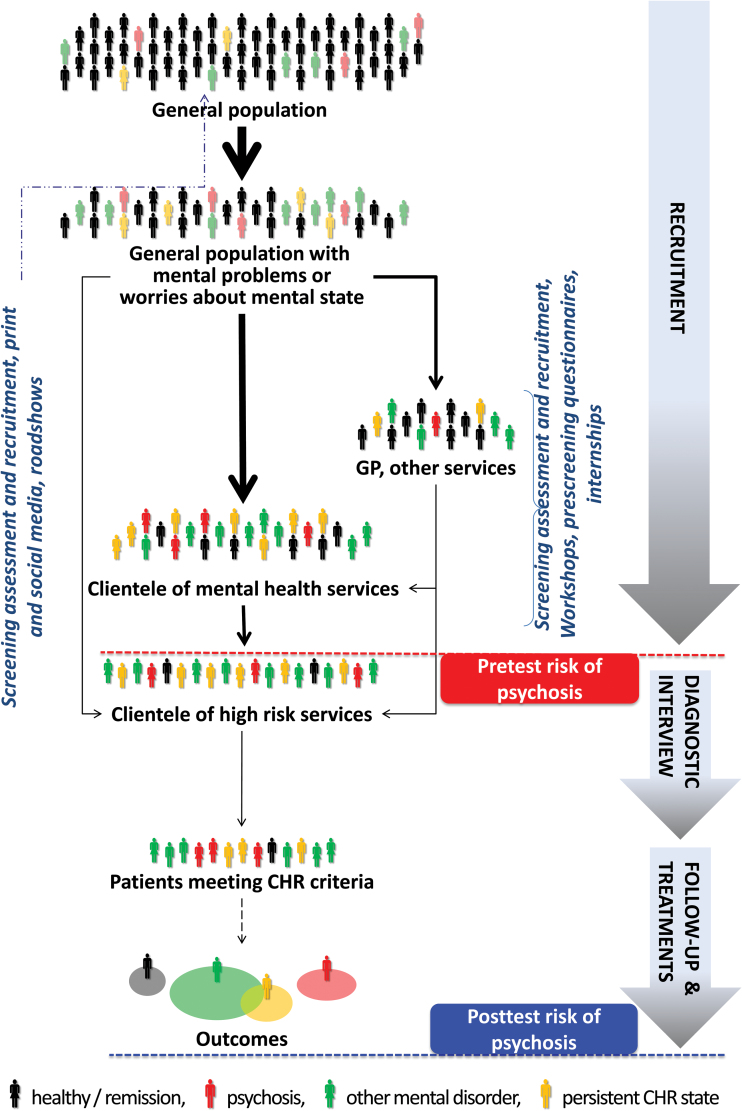
Illustration of hypothetical recruitment processes and, relatedly, risk enrichment of pretest risk of psychosis in clinical high-risk (CHR) samples, adapted from.44 In the general population, mental problems, mainly anxiousness, depressiveness45 and family/partner problems,38 and/or worries about one’s mental state may lead to help-seeking. Thereby, outreach campaigns targeting the general population might lead to seeking help directly at high-risk services (self-referrals) but might also unspecifically increase symptom awareness and, relatedly, worries about one’s mental state and help-seeking, thus potentially resulting in a risk dilution. Outreach campaigns targeting (mental) health providers may lead to selective referrals from these sources suspected to possibly suffer from a CHR state; thereby pretest risk enrichment will likely be highest in referrals from mental health professionals.17